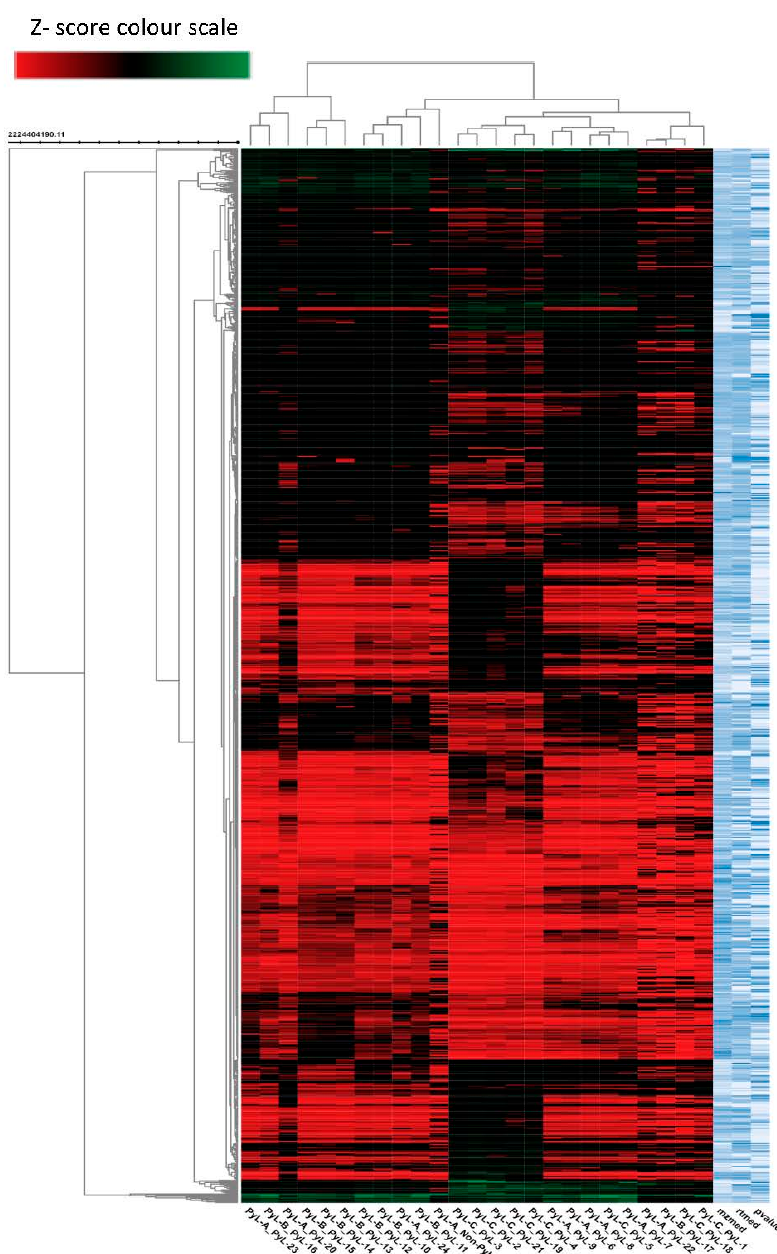
Figure 2. The heat map (dendrogram view) of the pyrolytic lignins, generated using the XCMS bioinformatics platform, showing the comparison of metabolite features between different samples. In dendrogram, each row represents a metabolite feature and each column represents samples. Metabolite features, the level of which varies significantly ( p < 0.05) are projected on the heat map and were used for sample clustering. The row Z score (scaled expression) value of each feature is plotted in red (high abundance) to green colours (low abundance).